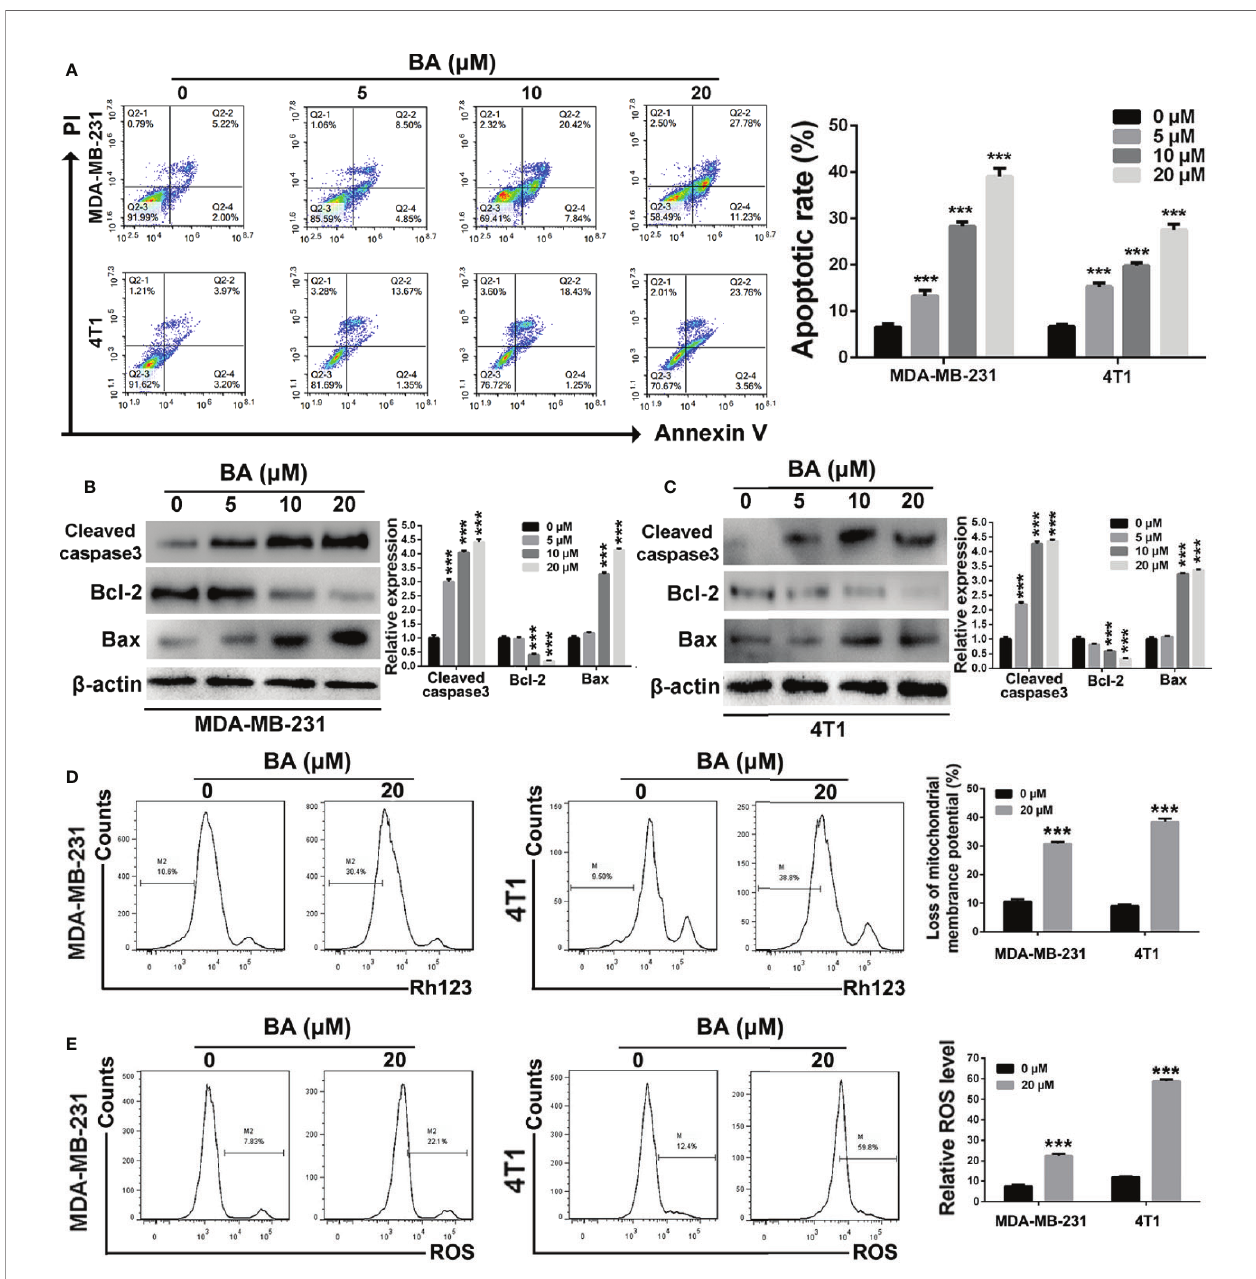
FIGURE 2 | BA triggered mitochondrial-mediated apoptosis in breast cancer. (A) Cells apoptosis were detected by Annexin V/PI dual staining assay after treatment with different concentrations (0, 5, 10, and 20 m M) of BA for 48 h. (B, C) Changes of apoptotic proteins in MDA-MB-231 and 4T1 cells were detected by western- blot assay. (D) Loss of mitochondrial membrane potentials of MDA-MB-231 and 4T1 cells were tested after different treatments. (E) The levels of cellular ROS of MDA-MB-231 and 4T1 cells were examined after different treatments. Signi fi cant differences are indicated as follows: *** P <